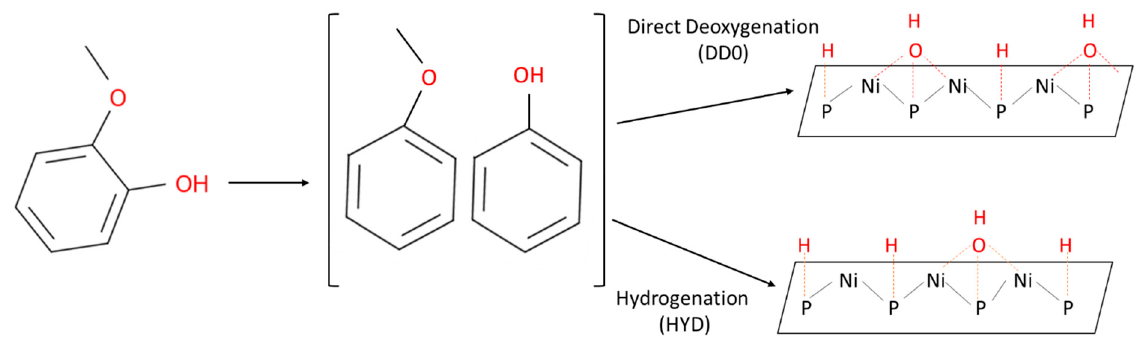
Figure 14. suggested reaction pathways for guaiacol HDO on Ni (cid:2870) P catalyst. Adapted from